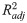
Relationship of fish condition (total weight adjusted for fork length with analysis of covariance) of B. meridionalis with altitude.The lines correspond to quadratic regressions by water flow regime. Total weight and fork length were log-transformed. Quadratic Radj2 was 0.406 for perennial reaches and 0.375 for the intermittent reaches.